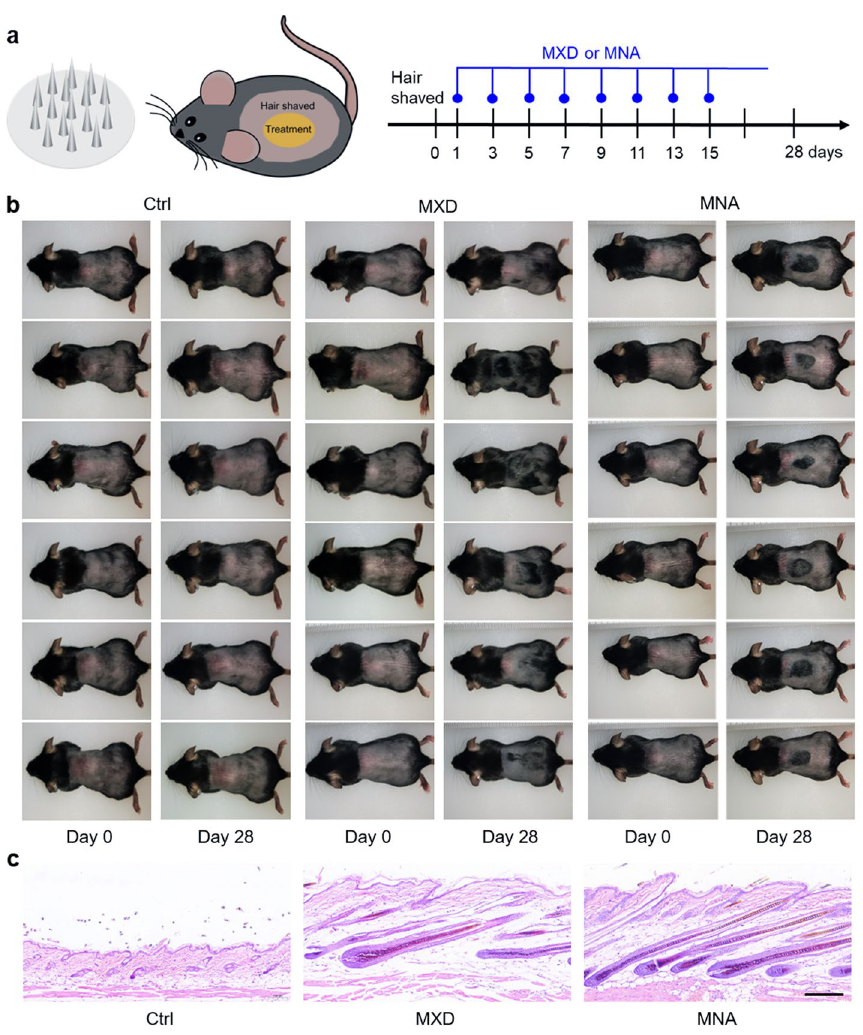
Fig. 3 Hair regeneration induced by customized MNA. a Schematic diagram of MXD and MNA treatment. b Photos of mice taken on day 0 and day 28 showed that there was no hair regeneration in the control group, messy hair regeneration in the MXD group, and round-shaped hair regeneration in the MNA group, respectively ( n 6). c H&E staining on day 28 revealed that the hair follicles in the control group were in the = telogen phase, and the majority of hair follicles in the MXD and MNA groups were in the anagen phase. (Scale bar: 200